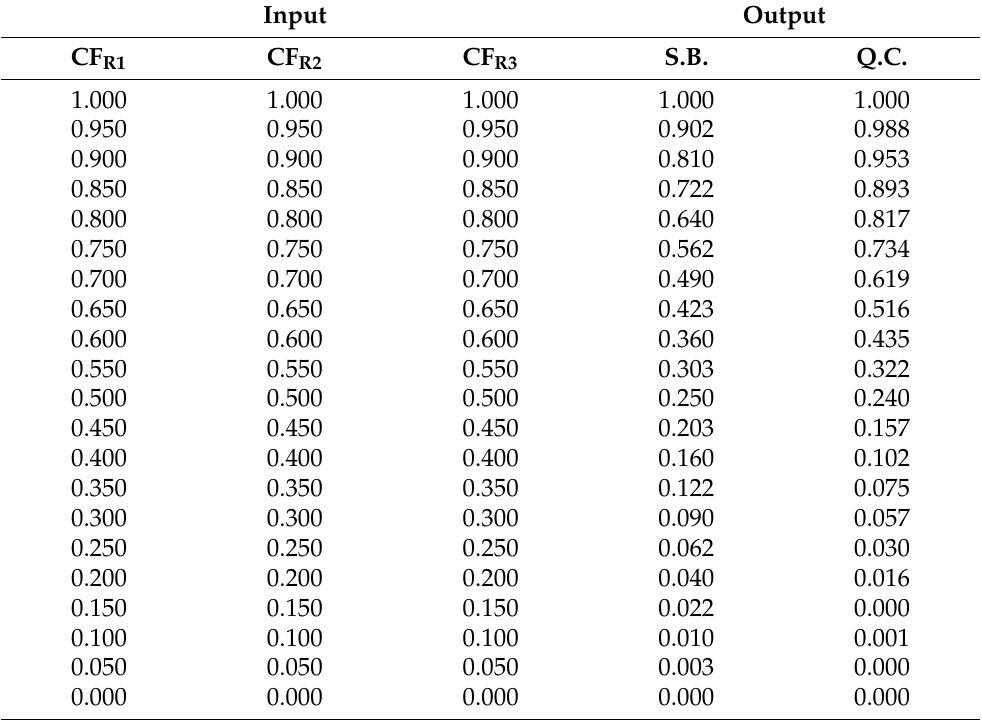
Table 8. Inputs and outputs for the uncertainty